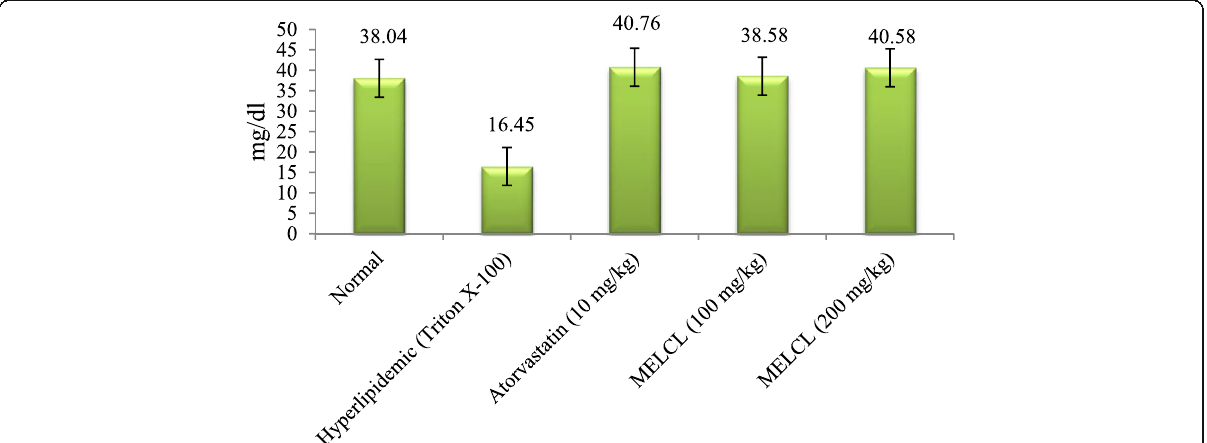
Fig. 2 Biochemical estimation of different groups for the level of High Density Lipoprotein (HDL). MELCL: Methanolic extract of Luffa cylindrica (L.)